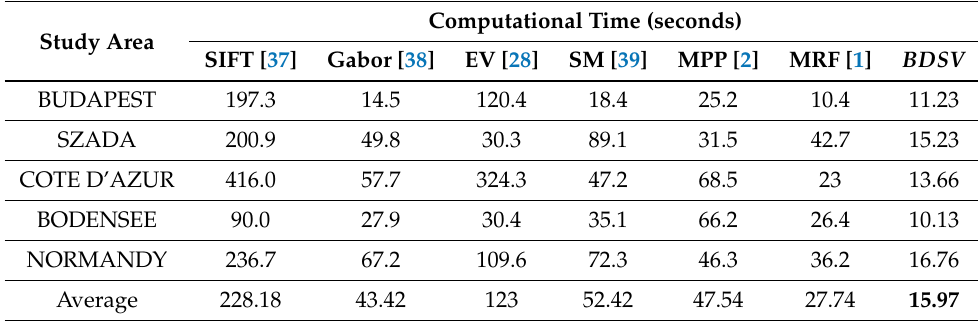
Table 5. Computational time of the benchmarked algorithms over the SztaKi–Inria dataset.